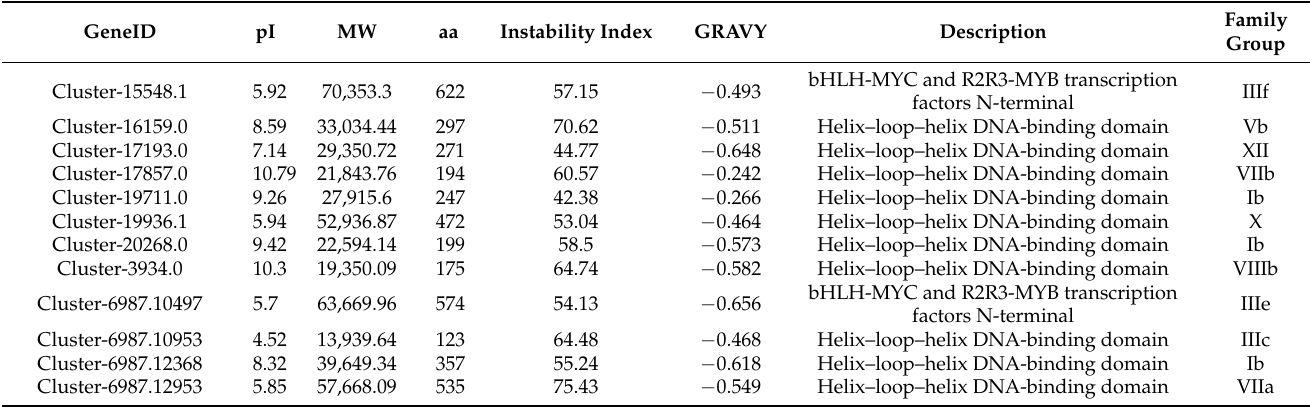
Table 1. A list of all bHLH genes identified in the D. kaki from the transcriptome unigenes.